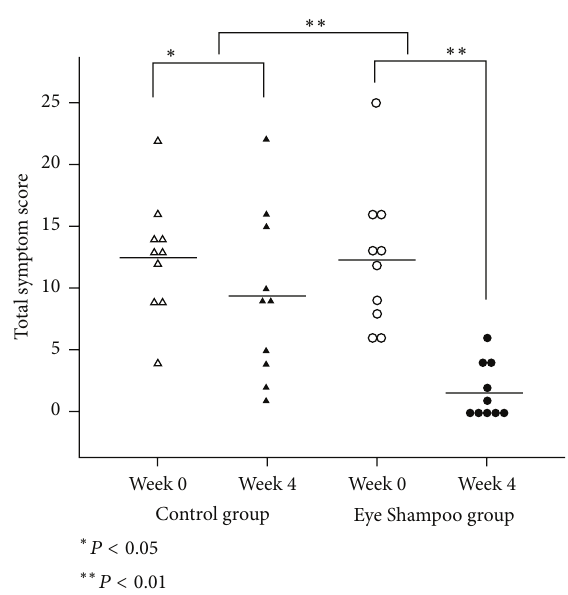
Figure 2: Subjective symptom scores for the two groups.